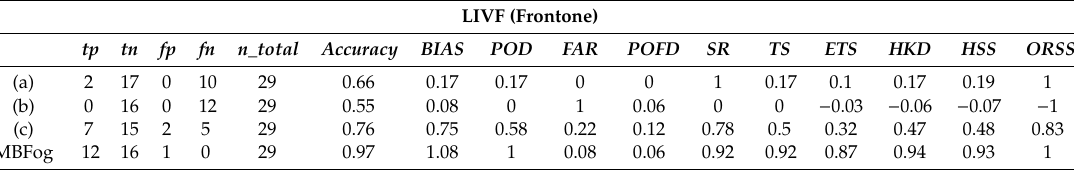
Table A8. Performances of several fog prediction methods for Frontone site LIVF